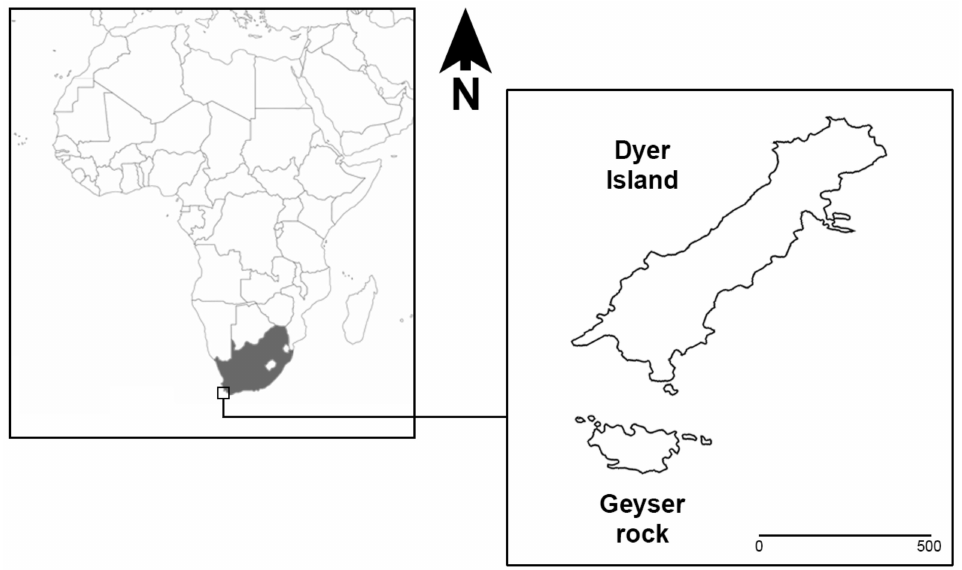
Figure 1. Dyer Island and Geyser Rock Nature